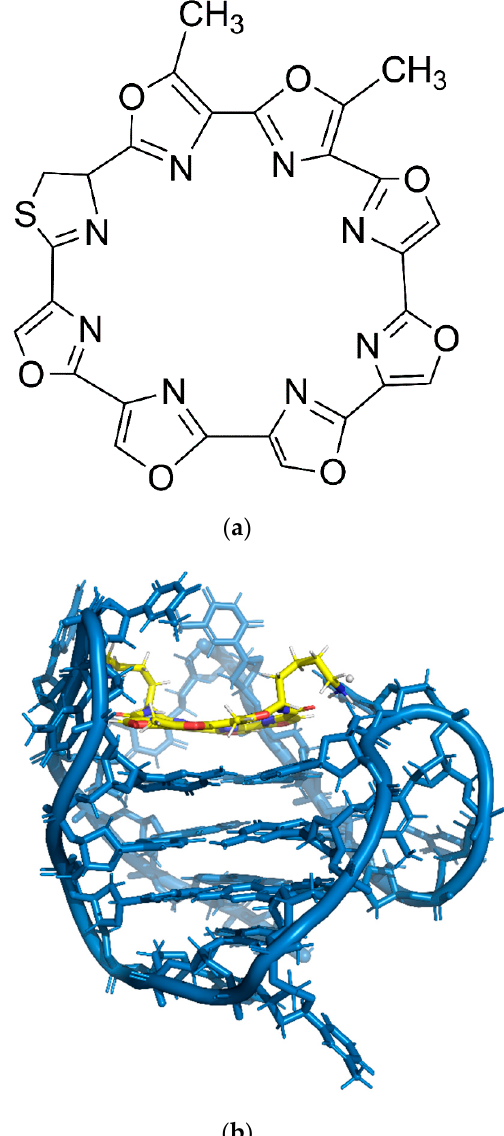
Figure 6. ( a ) Chemical structure of telomestatin. ( b ) Solution structure of an intramolecular (3 + 1) human telomeric G-quadruplex bound to a telomestatin derivative (PDB: 2MB3).